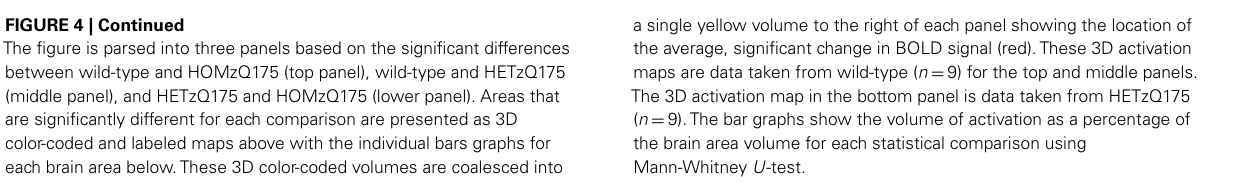
Mann-Whitney U -test.